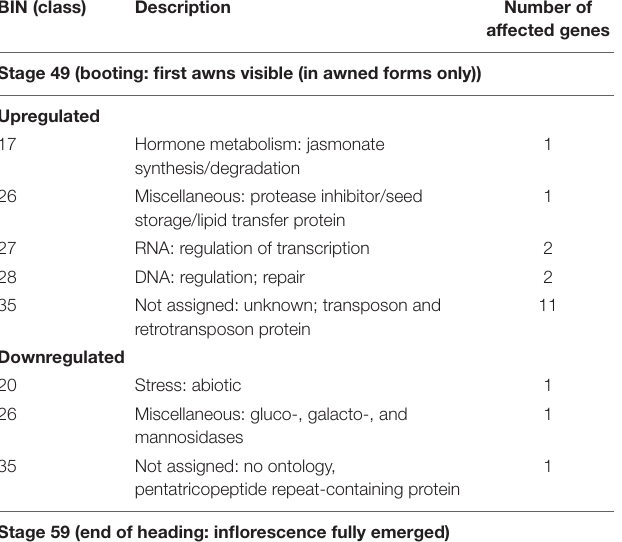
TABLE 2 | Functional annotation of most differentially expressed genes (adjusted p -value ≤ 0.01) generated according to Mercator tool (Lohse et al., 2014) in transgenic barley spikes of KD-CKX1 lines (5.8 and 17.10) compared to control plants, collected in different development stages 49 (booting) and 59 (heading), according to BBCH code for